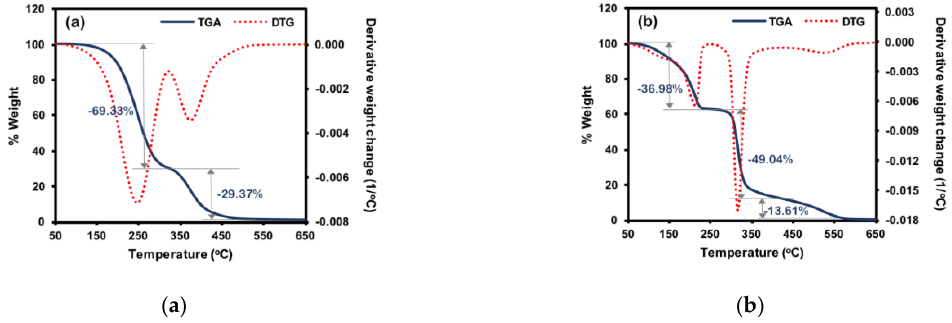
Figure 3. TGA and DTG of ( a ) polyester and ( b ) epoxy-corn starch sacrificial layers used for piezoelectric thick-film ceramic MEMS fabrication .